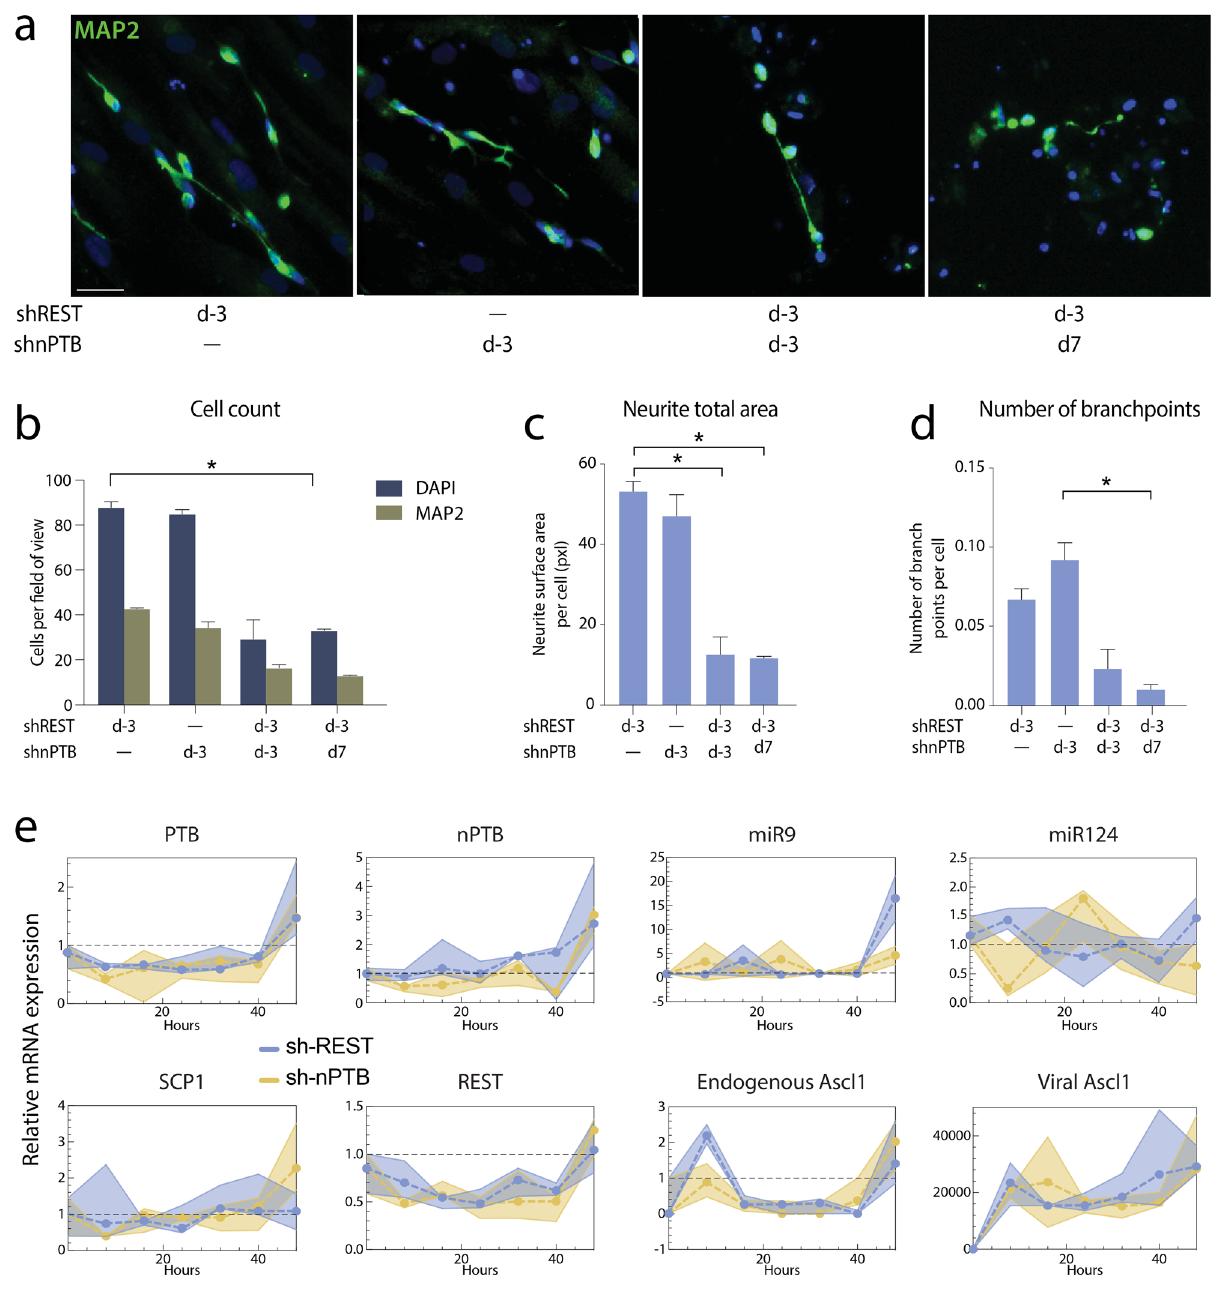
Figure 5. Experimental validation of the nPTB → PTB model. ( a ) Immunofluorescence staining of MAP2 (in green) showing reprogrammed iNs at day 25 post transduction. Cells are counterstained with DAPI (in blue). Scale bar = 150 µm. ( b ) Quantification of DAPI + and MAP2 + cells at day 25 post transduction, error bars are defined as S.E.M. ( c , d ) Quantification of neurite total area ( c ) and number of branch points, error bars are defined as S.E.M. ( d ) in iNs at day 25 post transduction. ( e ) Measured transcription levels. The dashed line represents the median of three replicates, surrounded by a shaded region between the minimum and maximum values at each time point. The measurements are normalized so that a value of 1 is equal to the fibroblast level, or to the detection limit in the case of Ascl1, which was not detected in fibroblasts. The graphs were generated using Graphpad Prism 8, the fluorescent images were put together using Adobe Photoshop 2020, the figures were ensembled using Adobe Illustrator 2020. https ://www.graph pad.com/scien tific -softw are/prism /, https :// www.adobe .com/se/produ cts/illus trato